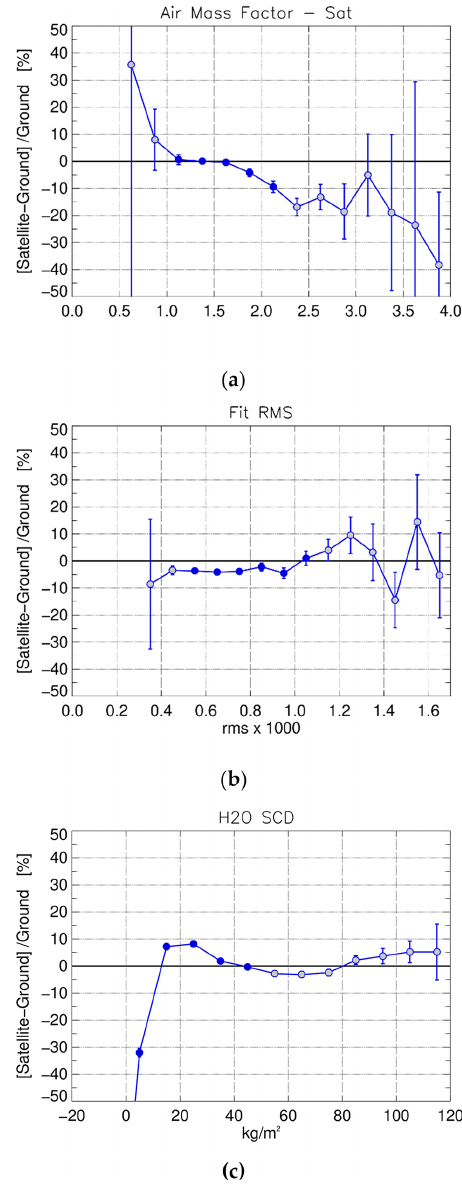
Figure 13. The dependence of the comparisons of satellite- to ground-based TCWV measurements on three parameters, namely TROPOMI/S5P (a) air mass factor, (b) rms and (c) water vapor slant column density. Grey dots represent bins containing < 3% of the total co-location